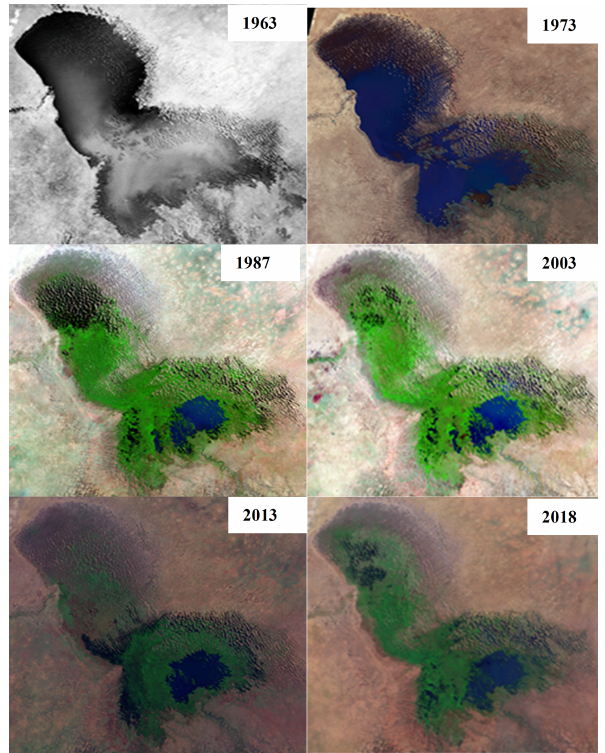
Figure 2. Chronological of changes in Lake Chad State from 1963 to 2018 (USGS,